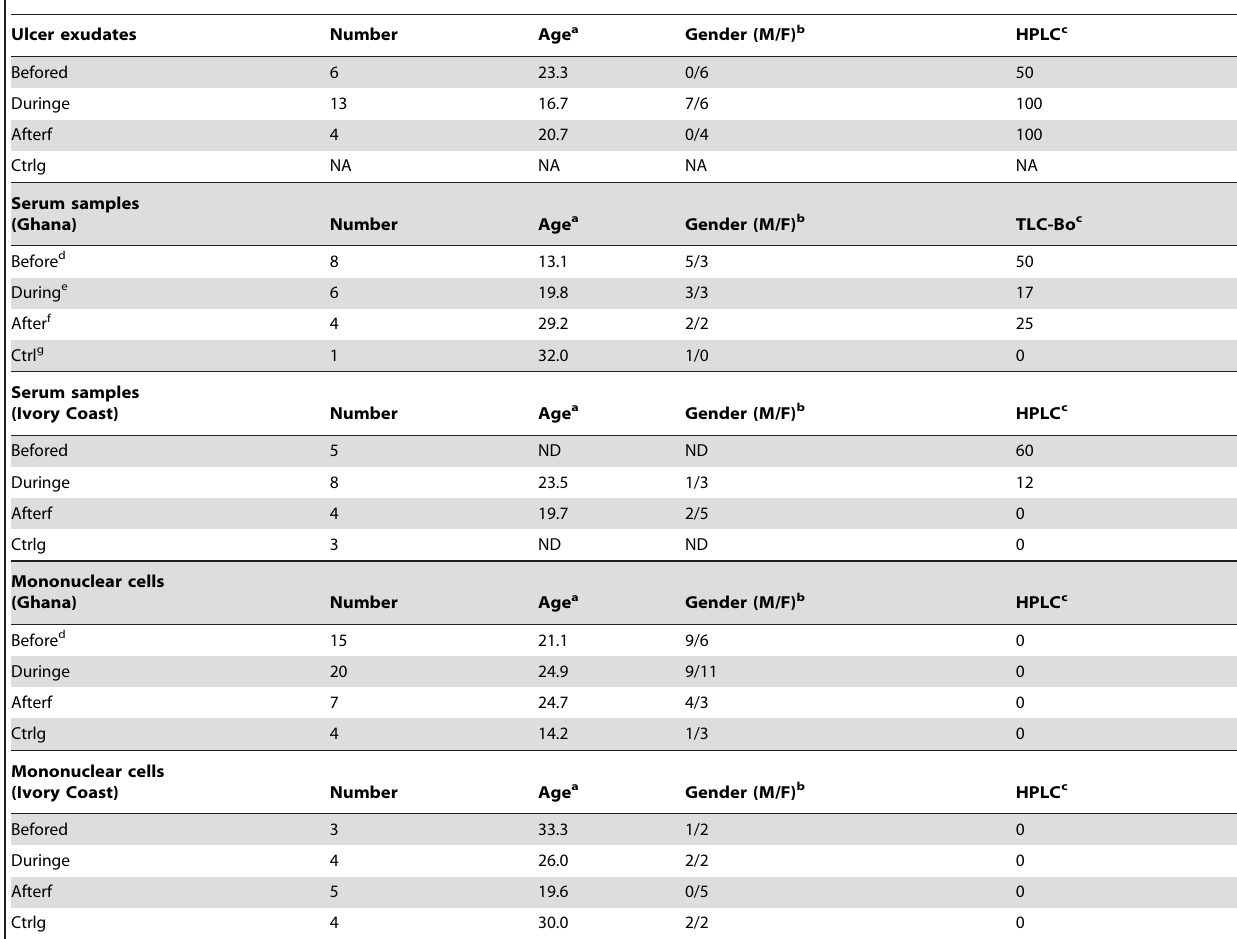
Table 1. Characteristics of patients and controls.